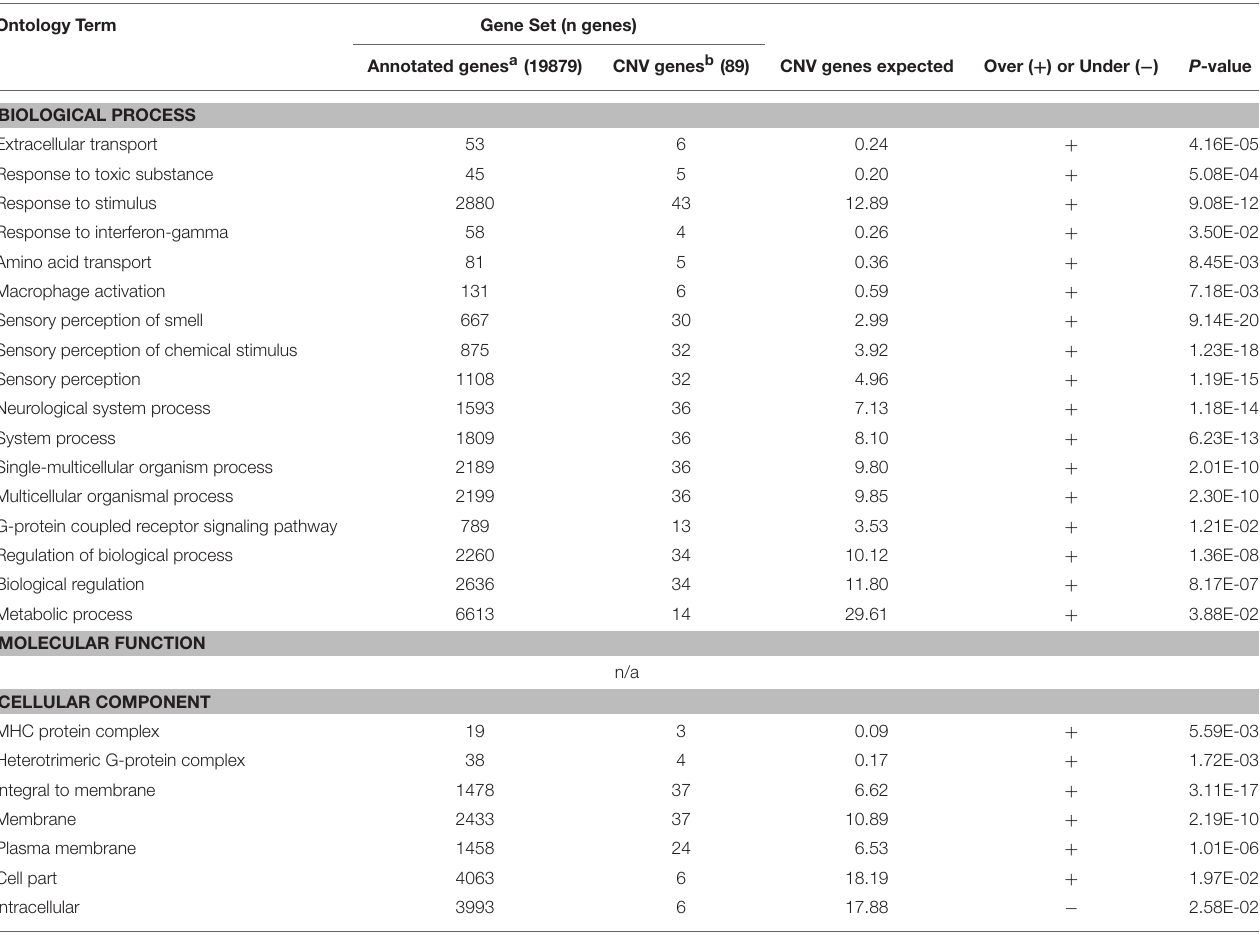
TABLE 3 | Significantly over- and underrepresented GO slim terms in the set of CNV genes. Ontology Term Gene Set (n genes) Annotated genes a (19879) CNV genes b (89) CNV genes expected Over ( + ) or Under ( − ) P